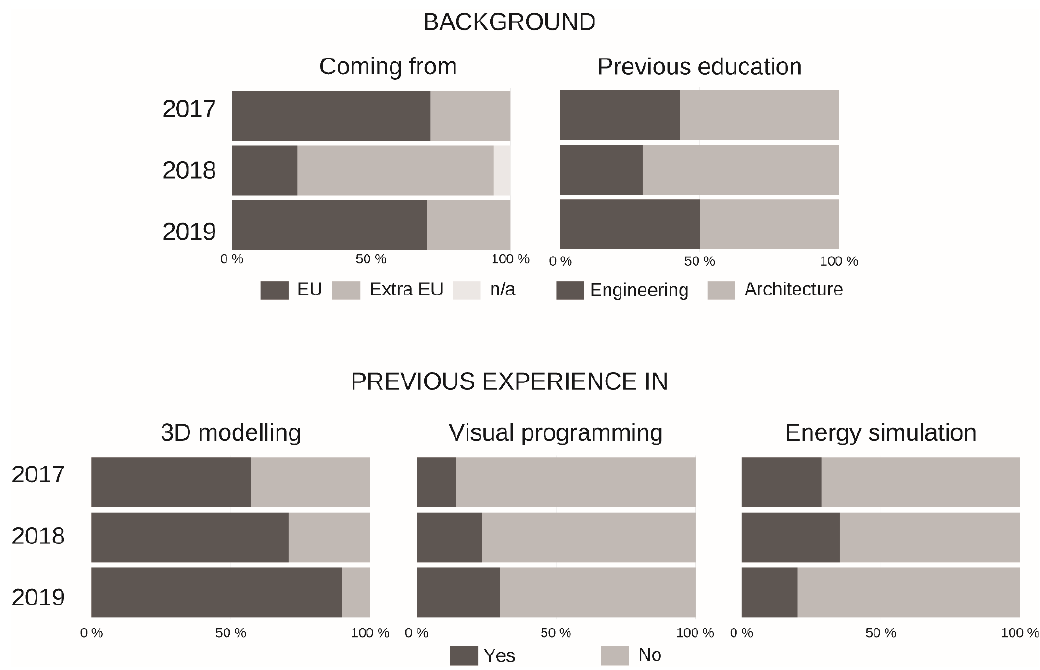
Figure 7. Students’ backgrounds and previous experience with BPS tools.